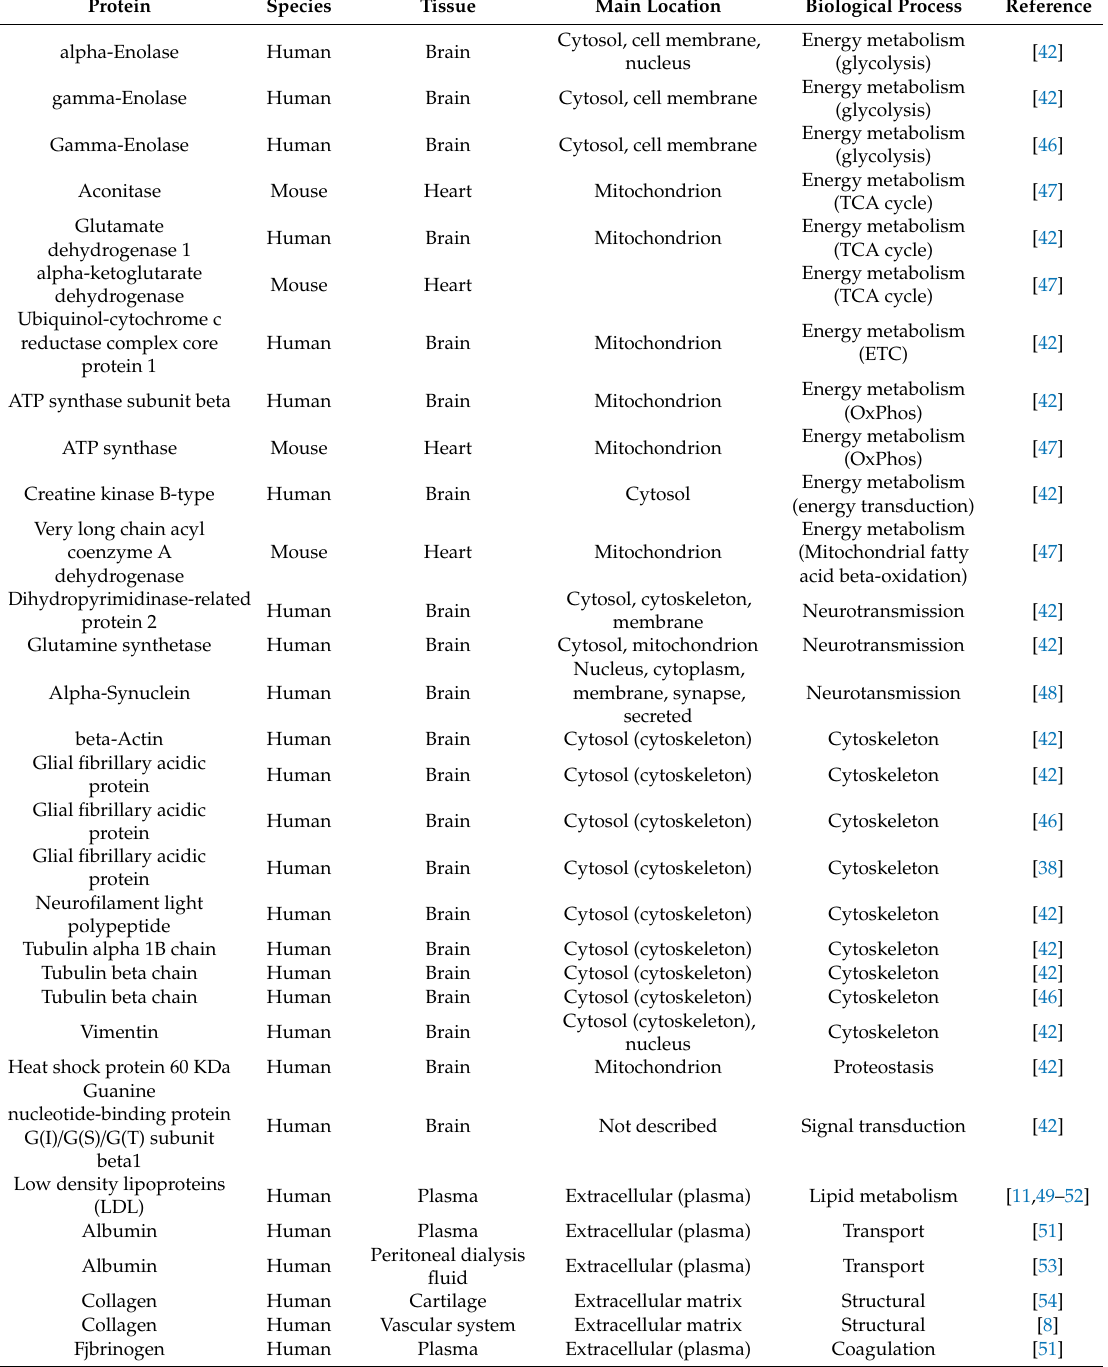
Table 1. Malondialdehyde-lipoxidized proteins identified by redox proteomics.